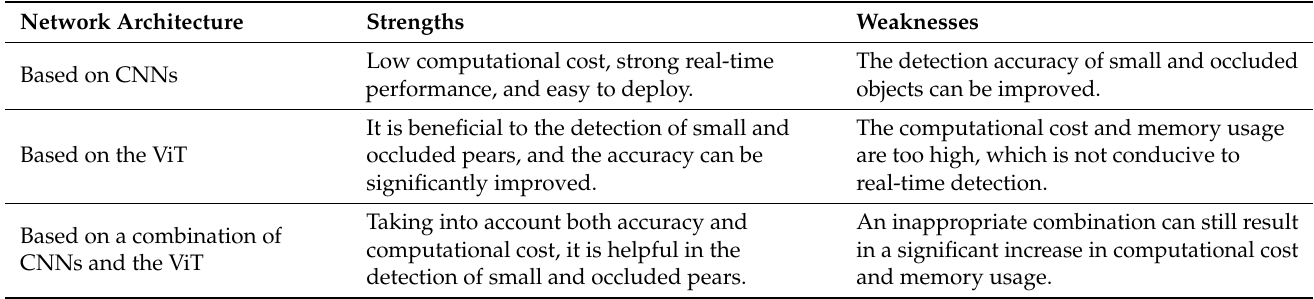
Table 1. The comparison of the strengths and weaknesses of the different network architectures.